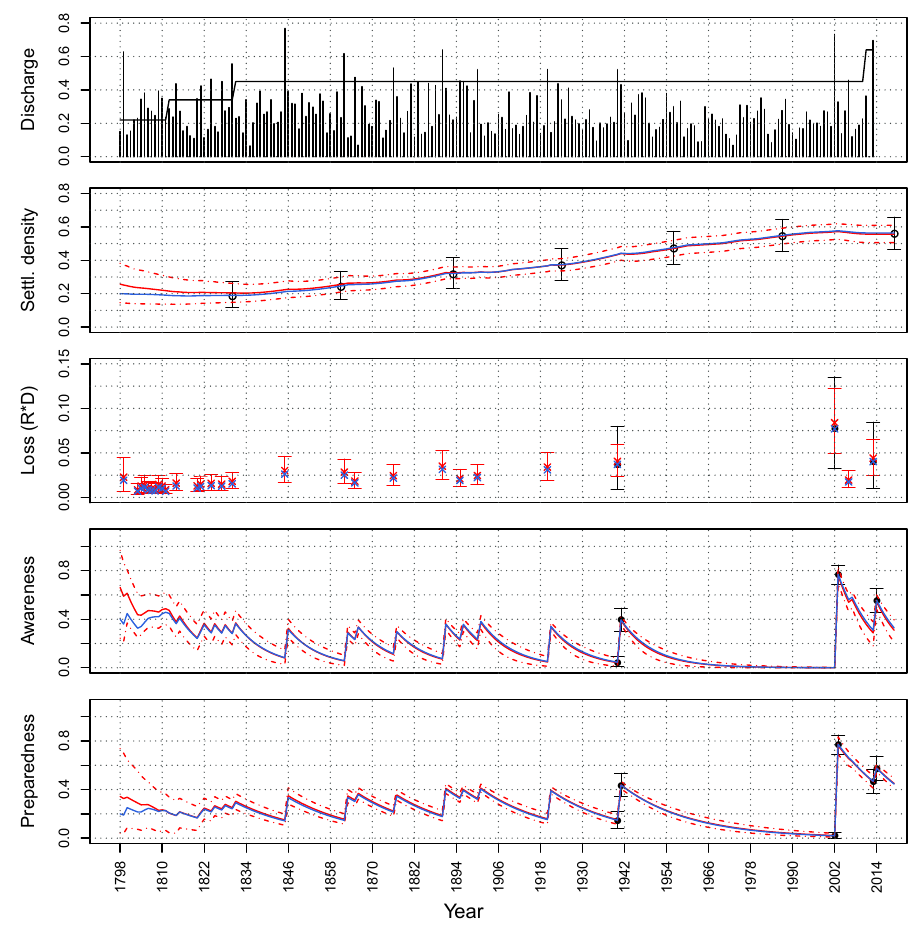
Figure 1. Generated dynamics of system variables, sampled data points and estimated time series. The generated dynamics of the system variables is represented in blue. Sampled data points are shown in black, with their 90% uncertainty bounds. Estimated time series are plotted in red, with the mean as a solid line and the 90% credible bounds as dotted